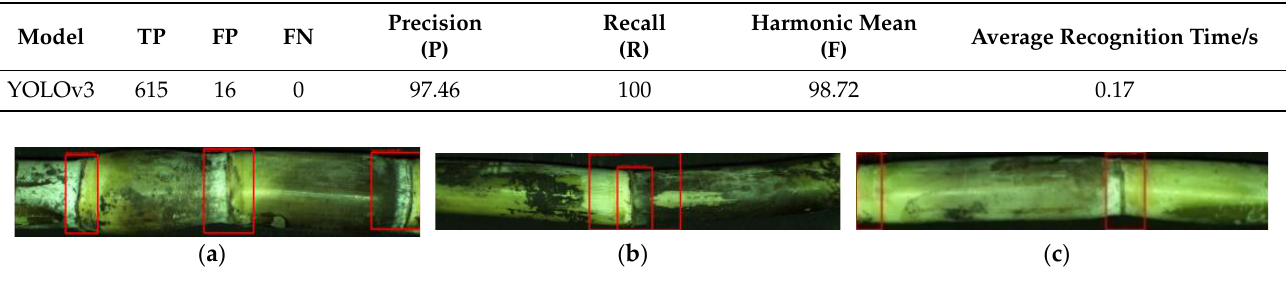
Figure 8. Output of the YOLOv3 network model: ( a ) two stem nodes, ( b ) repeated recognition, ( c ) non-stem-node recognition into stem node. ( c ) non-stem-node recognition into stem